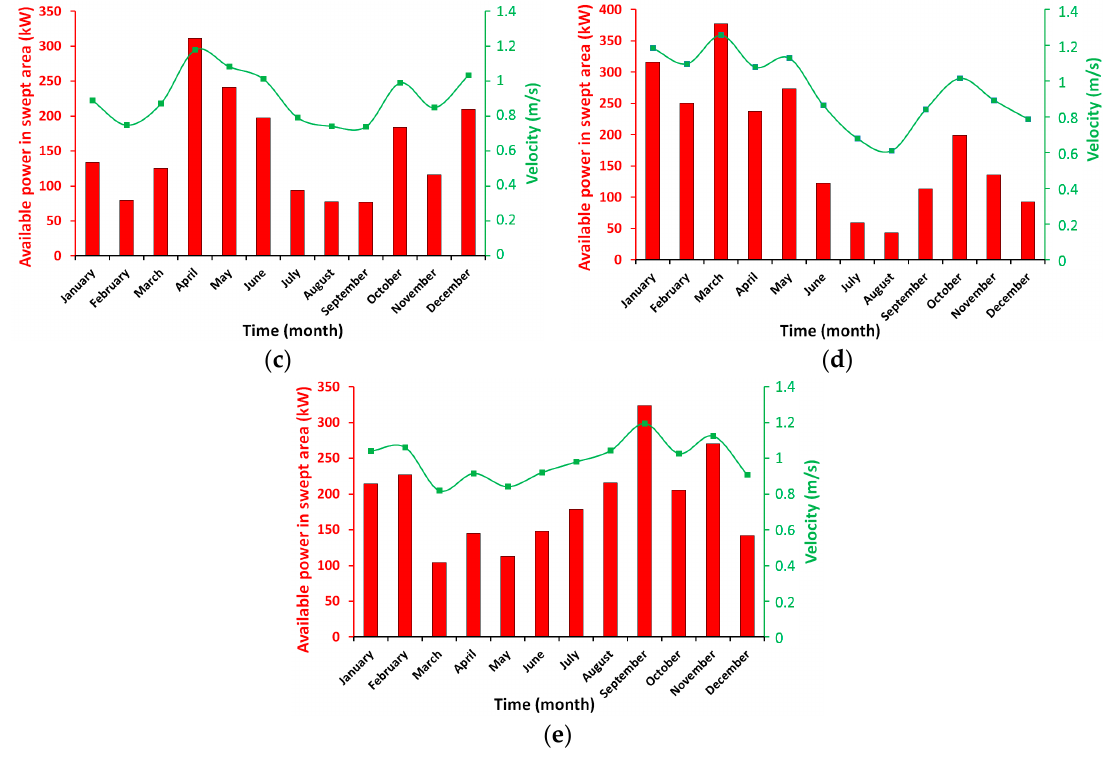
Figure 6. Tidal energy resource in the Mediterranean Sea. ( a ) 2010; ( b ) 2011; ( c ) 2012; ( d ) 2013; ( e ) 2014.